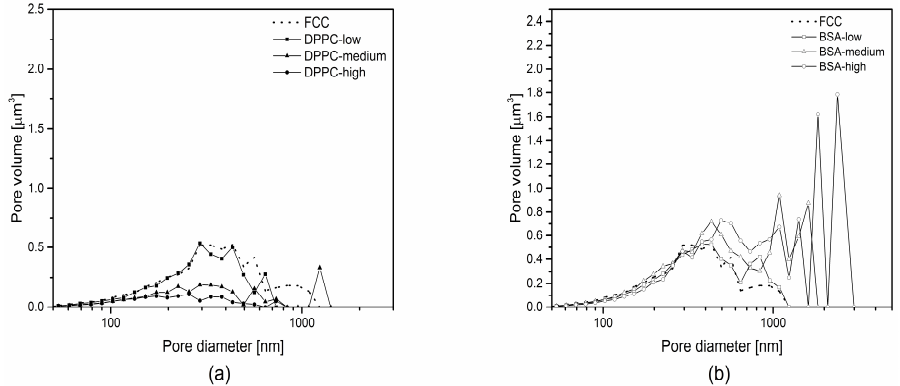
Figure 6. Pore size distribution based on FIB-SEM image analysis. Calculations were done assuming spherical pore shapes; (a) DPPC low, medium, and high loadings were compared to unloaded FCC; (b) BSA low, medium and high loadings were compared to unloaded FCC. Large voids (pore diameter > 1000 nm) in higher loadings of BSA are indicative of external crystallisation of BSA. Values are means of n ≥ 3.